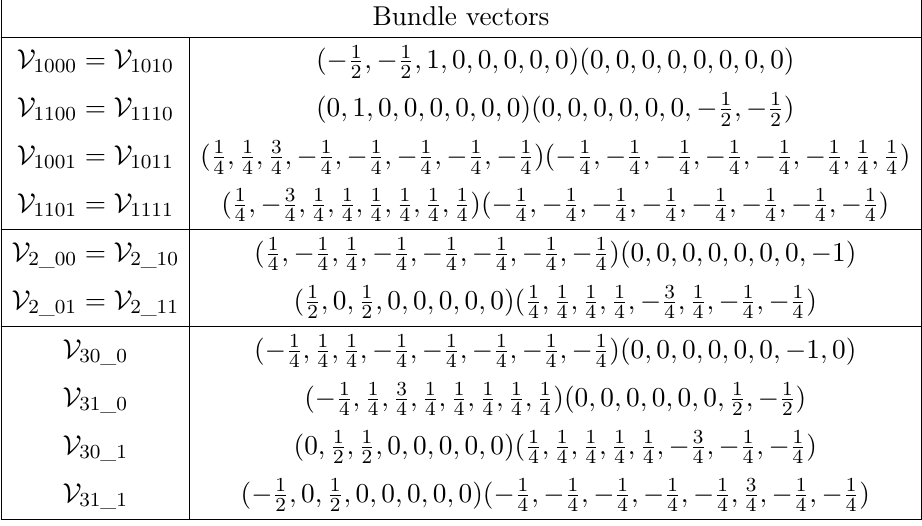
Table 8 . A set of bundle vectors associated to two shifts and four Wilson lines that satisfy the flux quantisation conditions and the Bianchi identities in all